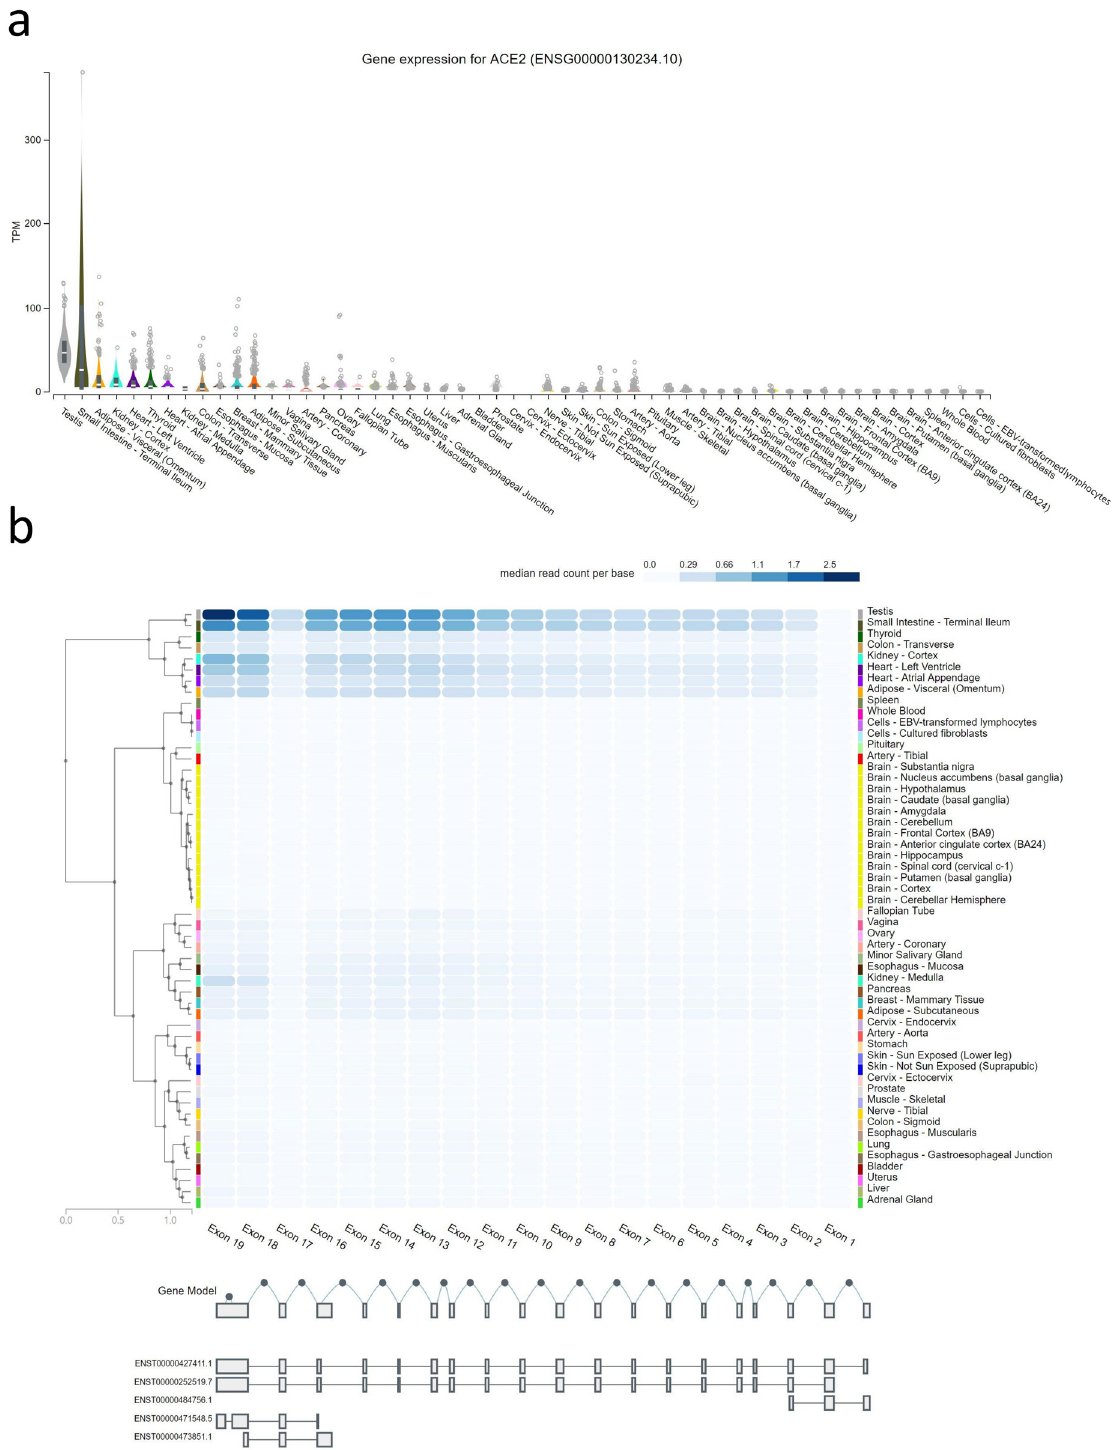
Figure 2: Gene expression of ACE2 in normal tissue ( GTEx ) . ( a ) Gene expression of ACE2 ( ENSG00000130234.10 ) . ( b ) Exon expression of ACE2 ( source: HGNC symbol; Acc: HGNC:13557 ) . ACE2: angiotensin - converting enzyme